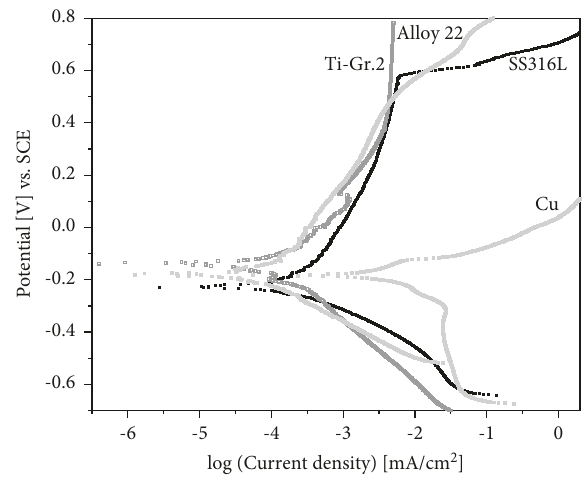
Figure 1: Potentiodynamic scans of SS316L, Ti-Gr.2, Alloy 22, and Cu in naturally aerated KURTgroundwater with 0.1M NaCl aggressive environment is ensured by chemically stable